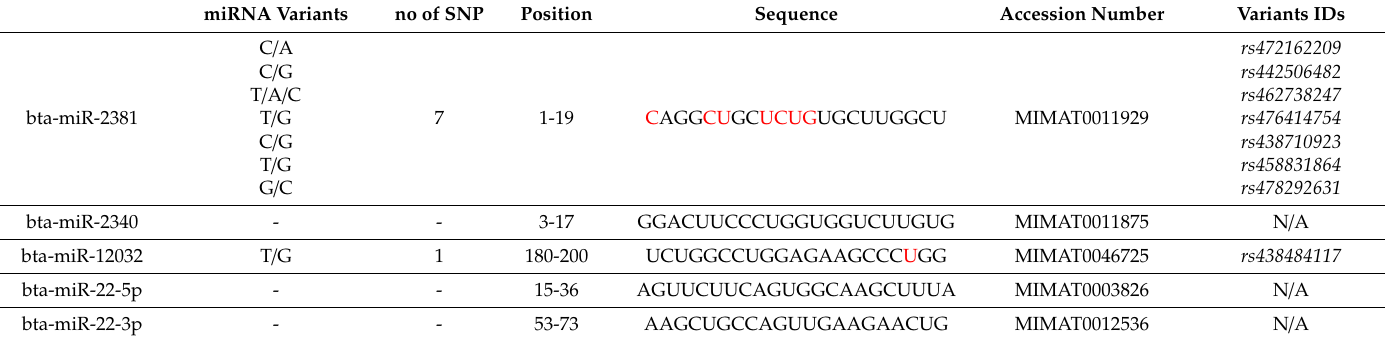
Table 4. List of micro RNAs (miRNAs) and associated SNP variants identified at the CD14 gene promoter